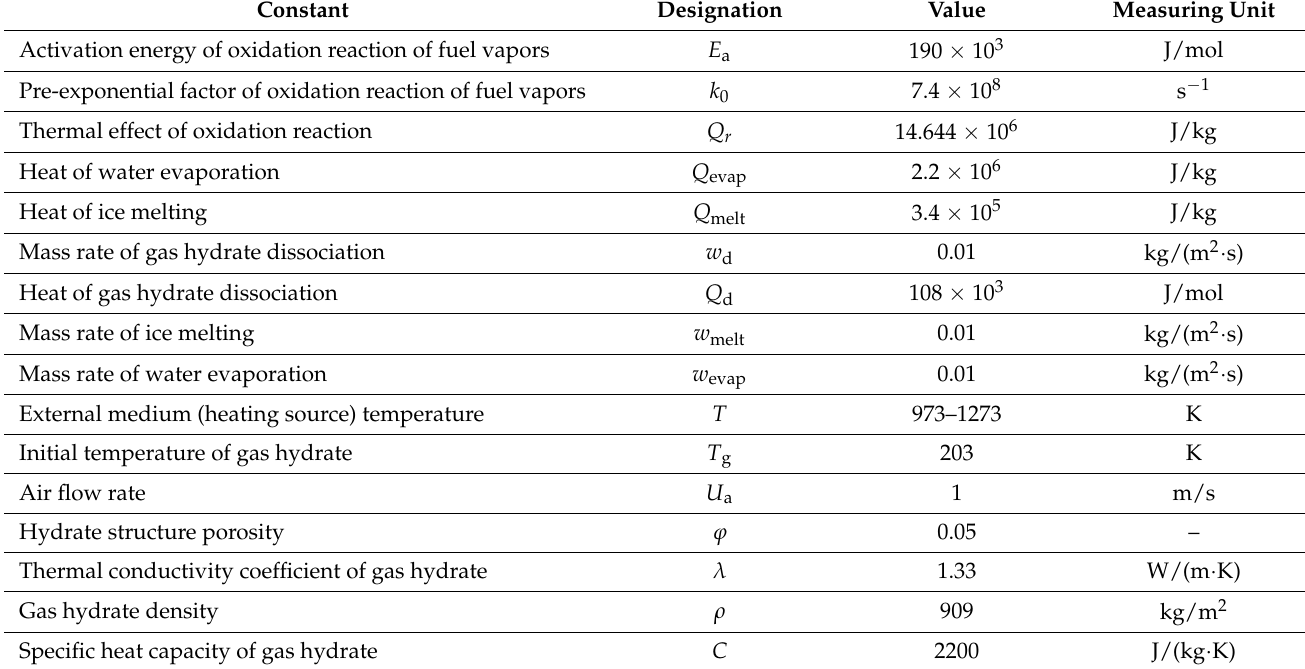
Table 1. The thermokinetic constants for modeling the processes of heating, evaporation, and ignition of methane-propane